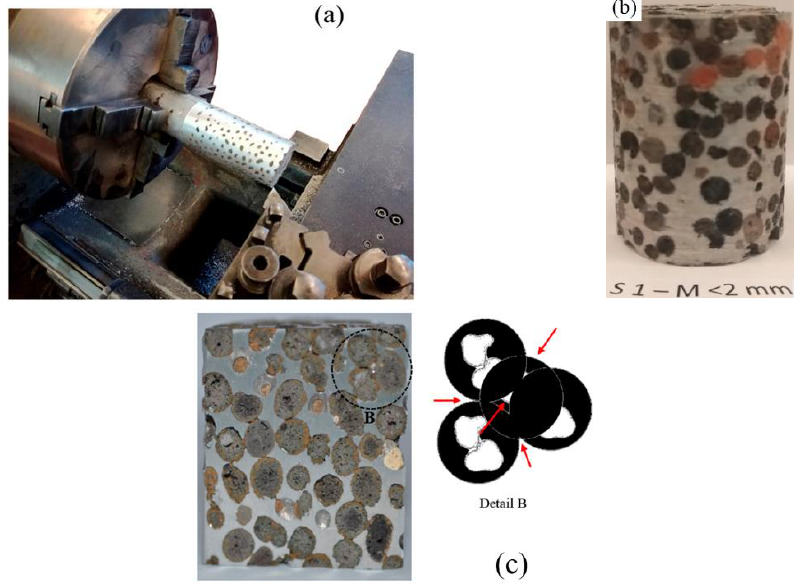
Figure 3. Composite sample representation: ( a ) machining process; ( b ) composite sample representation; ( c ) particle interaction schematics.